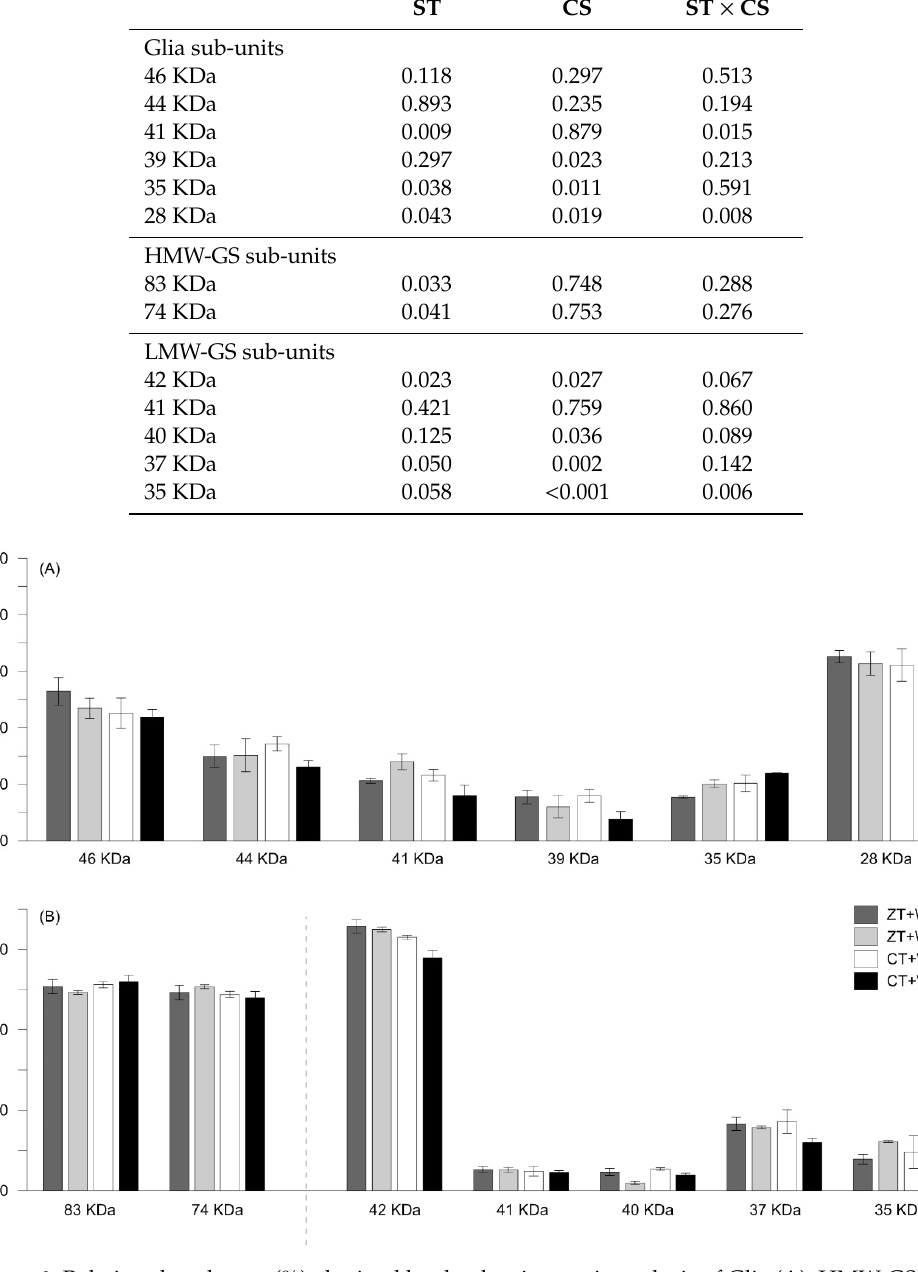
Figure 6. Relative abundances (%) obtained by the densitometric analysis of Glia ( A ), HMW-GS, and LMW-GS ( B ) sub-units of durum wheat in 2017. Treatments: CT, conventional tillage; ZT, zero tillage; WW, durum wheat monocropping; WF, durum wheat-faba bean rotation. Data are averages ± standard errors of n = 3 independent replicates.